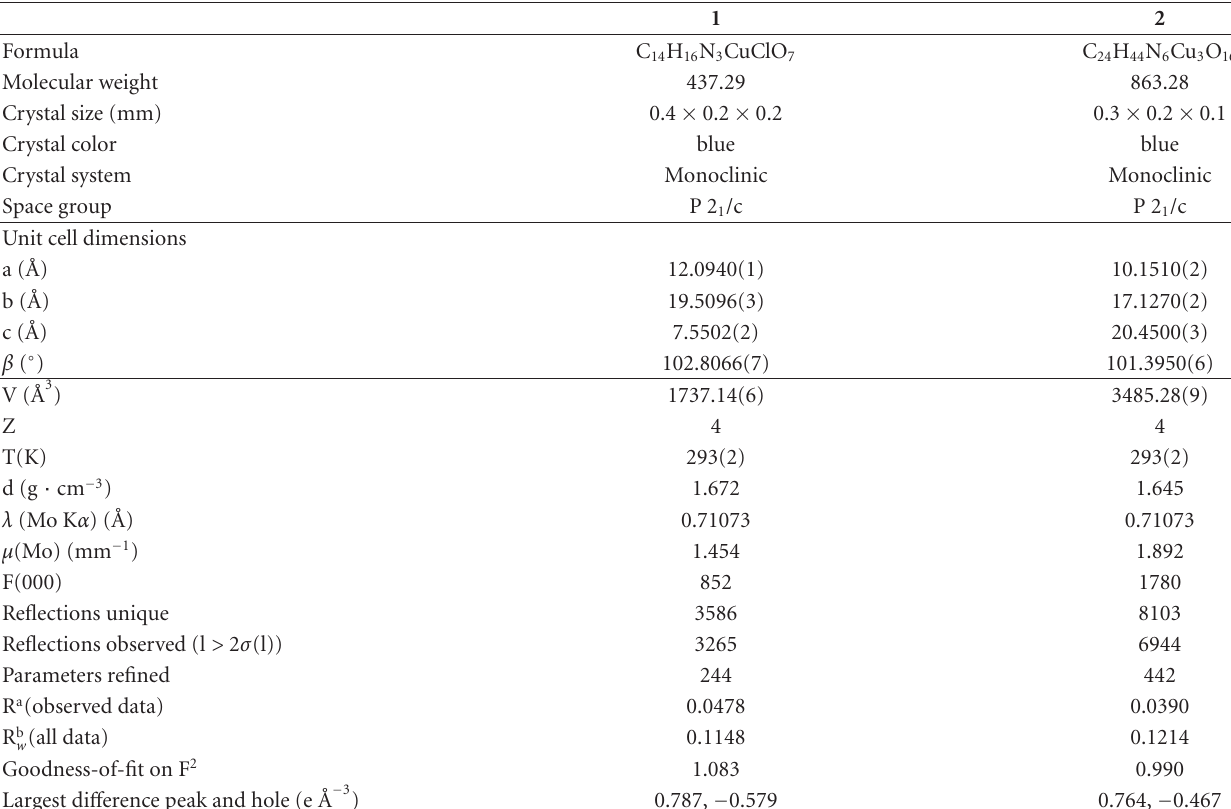
Table 1: Selected crystallographic data for [(bpy)Cu(ACC)(H 2 O)] · ClO 4 ( 1 ) and [Cu(ACC) 2 ] 3 · 4H 2 O ( 2 ).